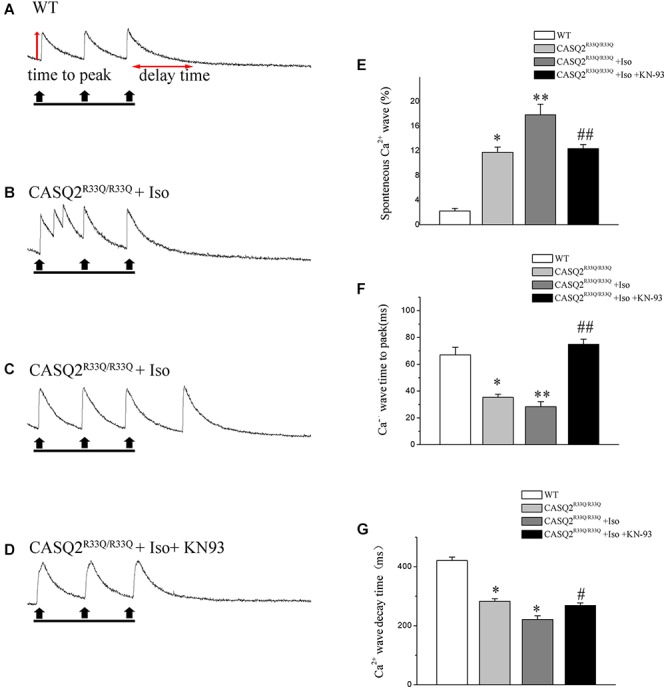
(A) Original recordings of spontaneous Ca2+ wave in the WT and Casq2R33Q/R33Q atrial myocytes, as well as Casq2R33Q/R33Q atrial myocytes with 1 μM isoproterenol. (B) A line record of Ca2+ waves that elicit EADs during an long AP and (C) a DAD after a regular AP. (E–G) Spontaneous Ca2+ release events reflected by the incidence of reactive Ca2+ wave (%), Ca2+ wave time to peak (ms), and Ca2+ wave decay time (ms) on each group. ∗P < 0.05 vs. WT, ∗∗P < 0.01 vs. WT. #P < 0.05 and ##P < 0.01 when comparing the Iso group with the Iso plus KN93 group.